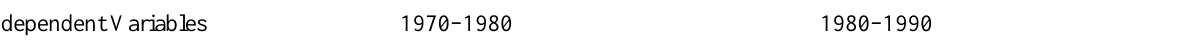
Table 7. Unstandardized coefficients for regional restructuring estimates and relationships between structural underclass indicators, Pittsburgh Standard Metropolitan Statistical Area Independent